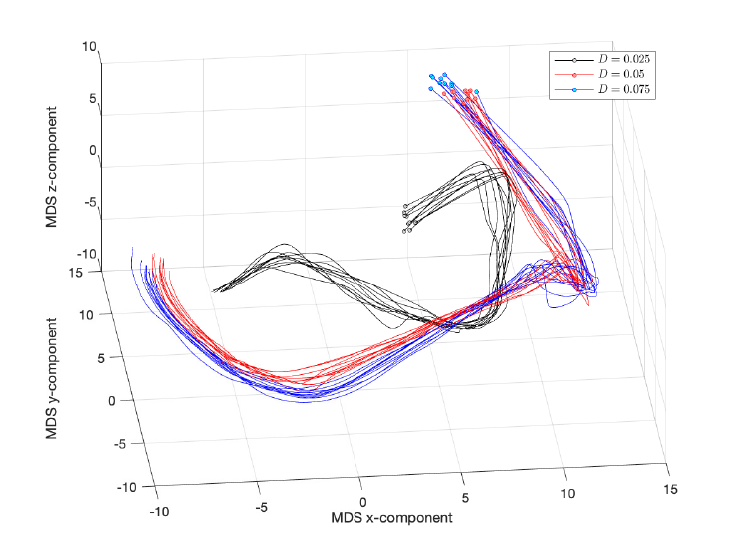
Figure 20. The 3-dimensional MDS locus, using the Lorentzian distance (4), t ∈ { 1, . . . ,30 } , for D = { 0.025,0.05,0.075 } ( N = 500, δ = 0.1, p 1 = 0.1, p 2 = 0.9, p 3 = 0.7, p 4 = 0.05, p 5 = 0.02, α = 2 and N h → ∞